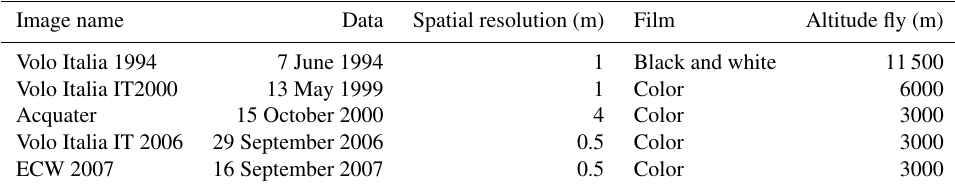
Table 2. Characteristics of the aerial images used for the analysis of the case study.